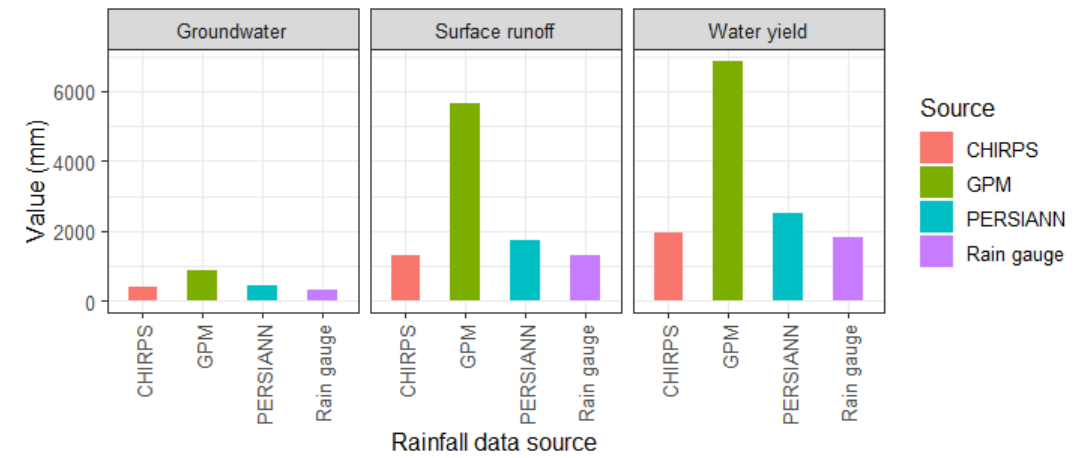
Figure 11. Comparison of water balance components: surface runoff, groundwater and water yield based on source of rainfall data at simulated year 2010.